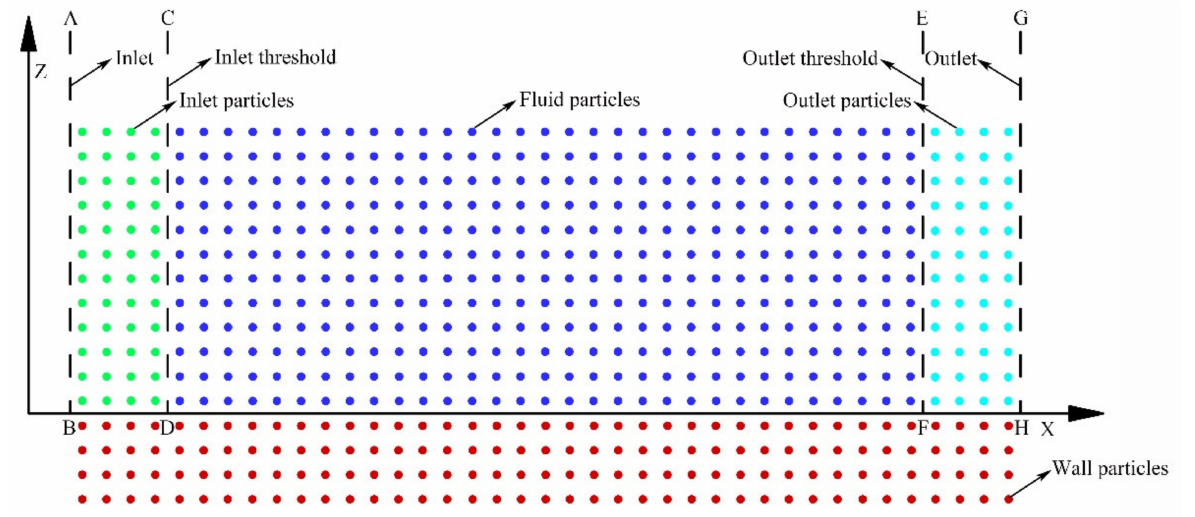
Figure 1. Sketch of the computational